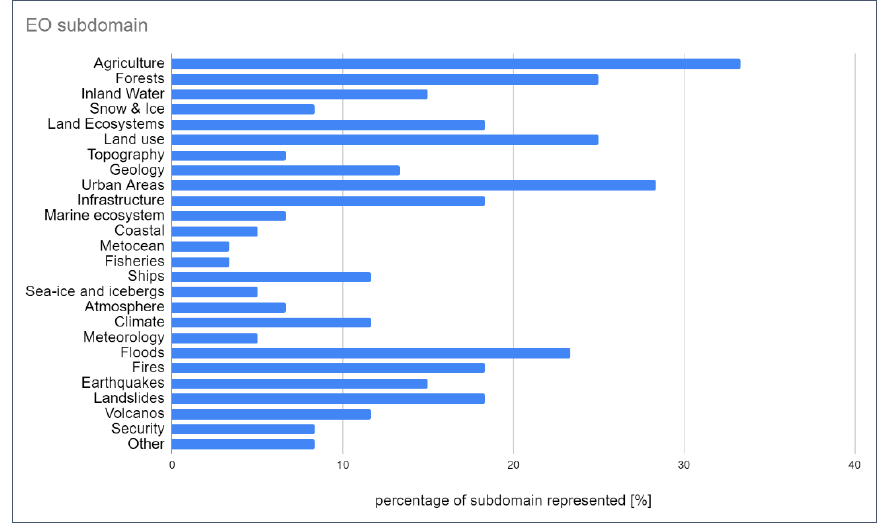
Figure 13. Aggregation of EO subdomain representation (users and